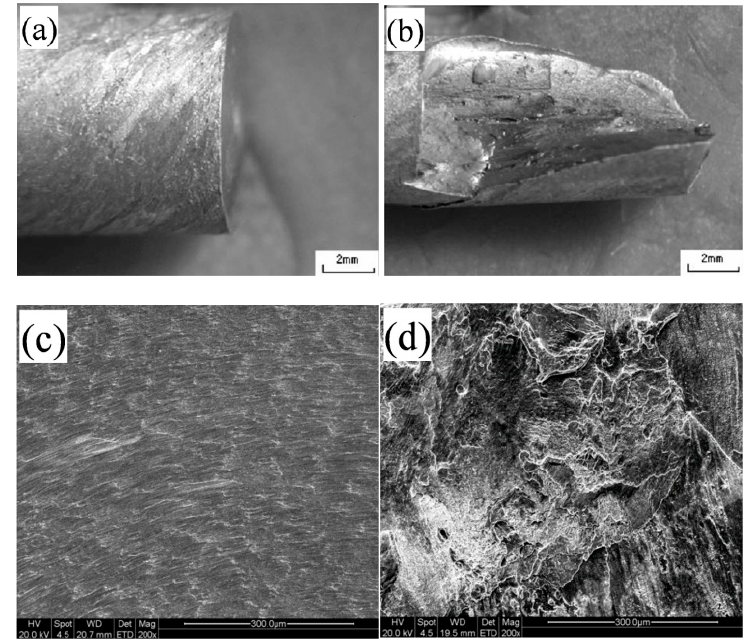
Figure 2. Torsional fracture morphology of the wires: ( a , c ) 17 circles, flat fracture; ( b , d ) 2 circles, stratified fracture.